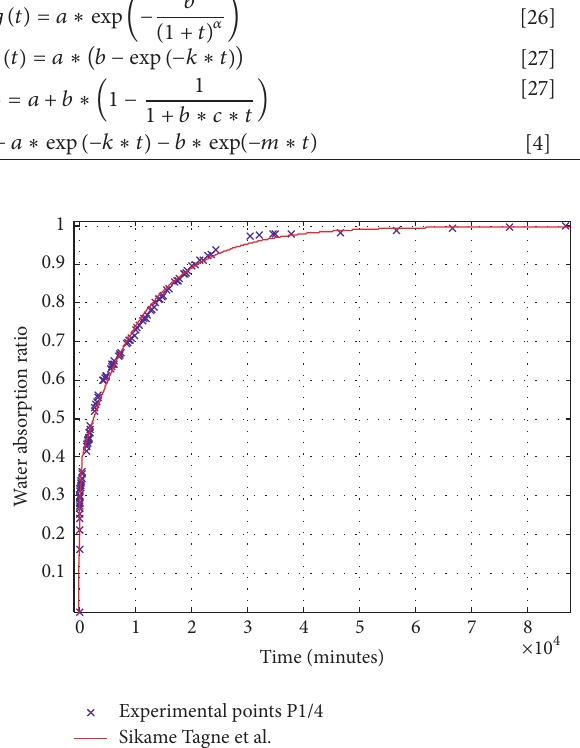
Figure 6: Experimental points and model of Sikame Tagne [4] of the pith of Raffia vinifera from the center of the base